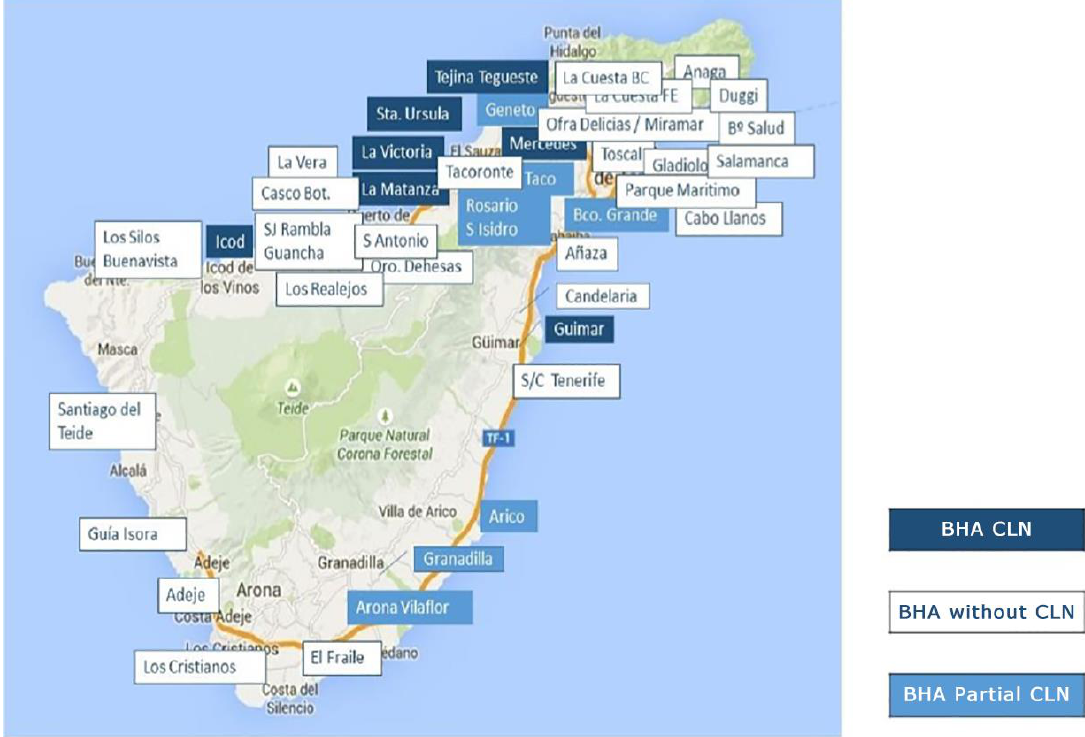
Figure 1. Distribution of health basic areas in Tenerife with and without community liaison nurse.